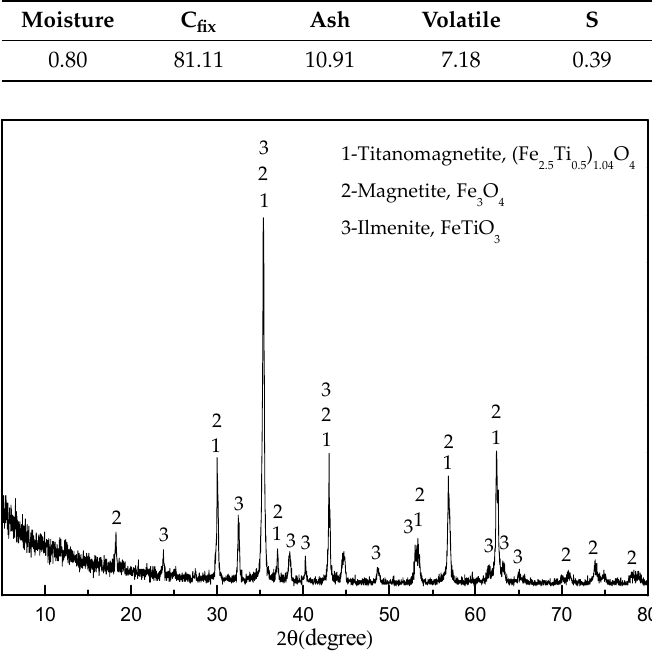
Figure 1. XRD patterns of the titanomagnetite concentrate.